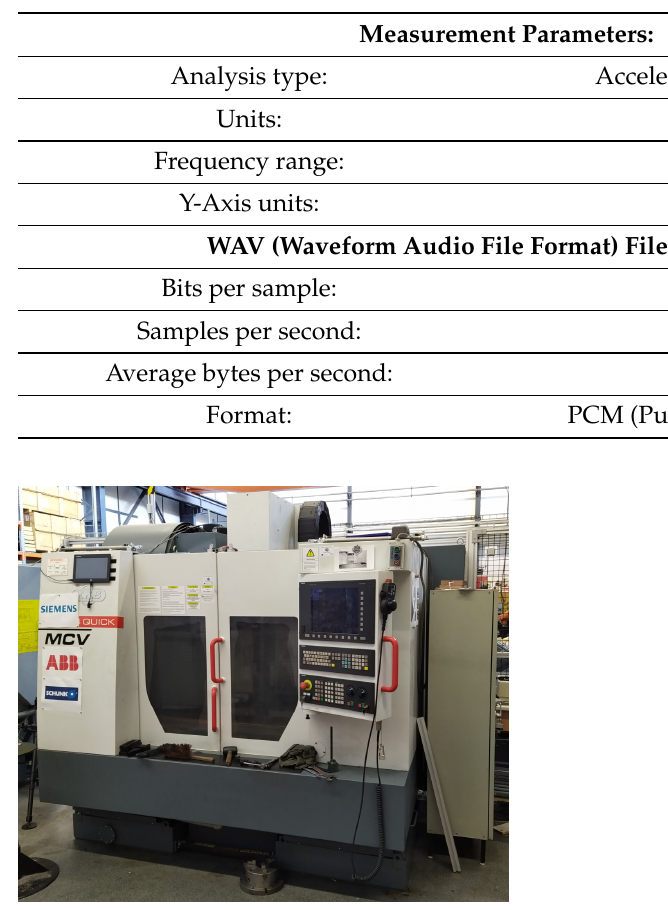
Table 1. Measurement parameters of Microlog CMXA48.